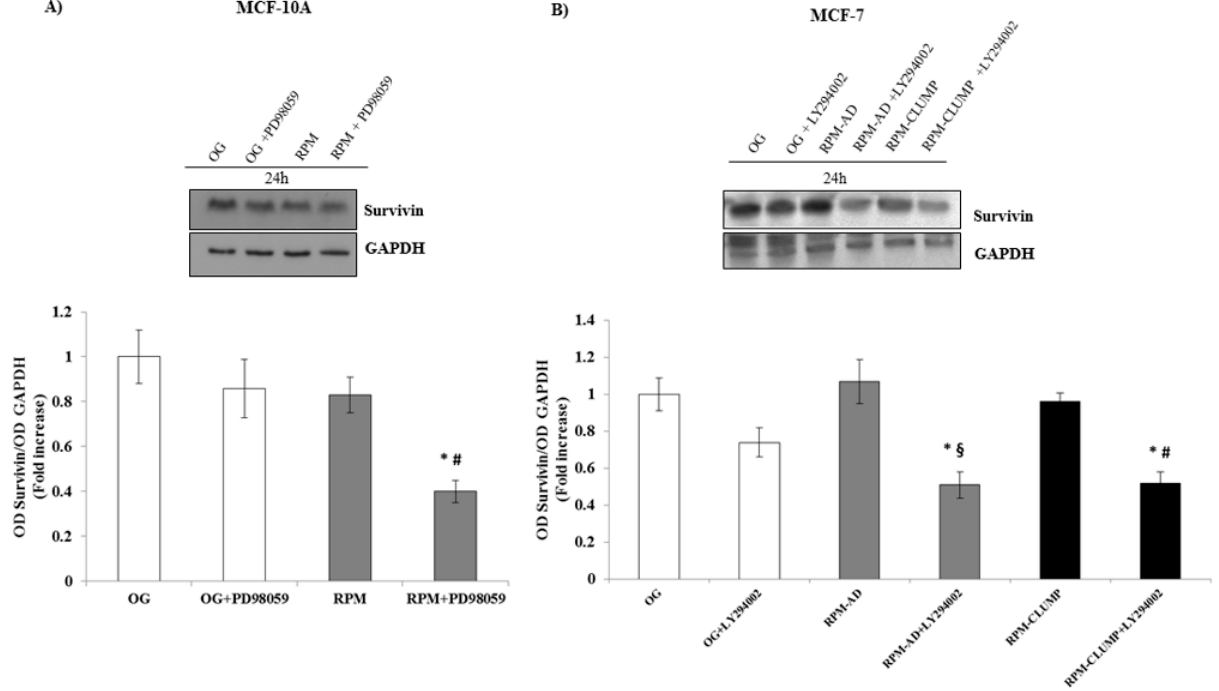
Figure 17. Immunoblot bar chart showing the expression of survivin in MCF-10A ( A ) and in MCF-7 ( B ) in on-ground control cells, RPM adherent cells, and RPM cell clumps at 24 h w/o the p-ERK inhibitor, PD89059, and w/o the p-AKT inhibitor, LY294002, respectively. Columns and bars represent densitometric quantification of the optical density (OD) of a specific protein signal normalized with the OD values of the GAPDH serving as the loading control. Each column represents the mean value ± SD of three independent experiments. In MCF-10A, * p < 0.05 vs. OG; # p < 0.05 vs. RPM by ANOVA followed by Bonferroni post-test. In MCF-7, * p < 0.05 vs. OG; § p < 0.05 vs. RPM-AD; # p < 0.05 vs. RPM-CLUMP by ANOVA followed by Bonferroni post-test.